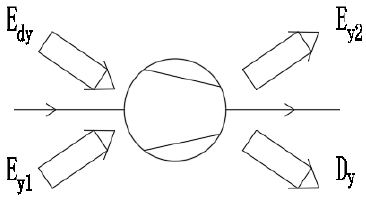
Figure 2. Schematic diagram of compressor exergy balance model.